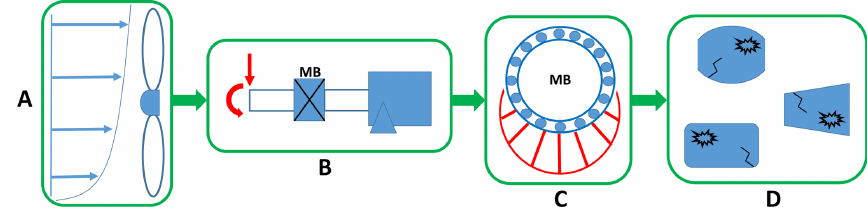
Figure 1. Flow diagram capturing the loading relationships which ultimately lead to main-bearing damage and